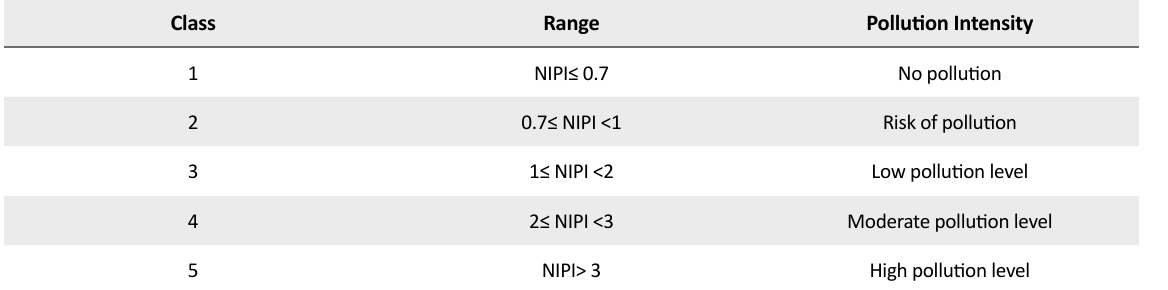
Table 3. Classification of NIPI index